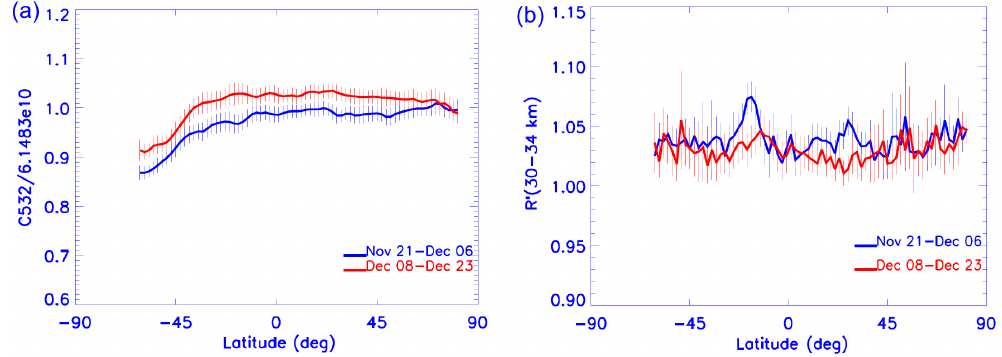
Figure 15. Same as in Fig. 13 but using data before (21 November–6 December 2009) and after (8–23 December 2009) the boresight alignment procedure on 7 December 2009.